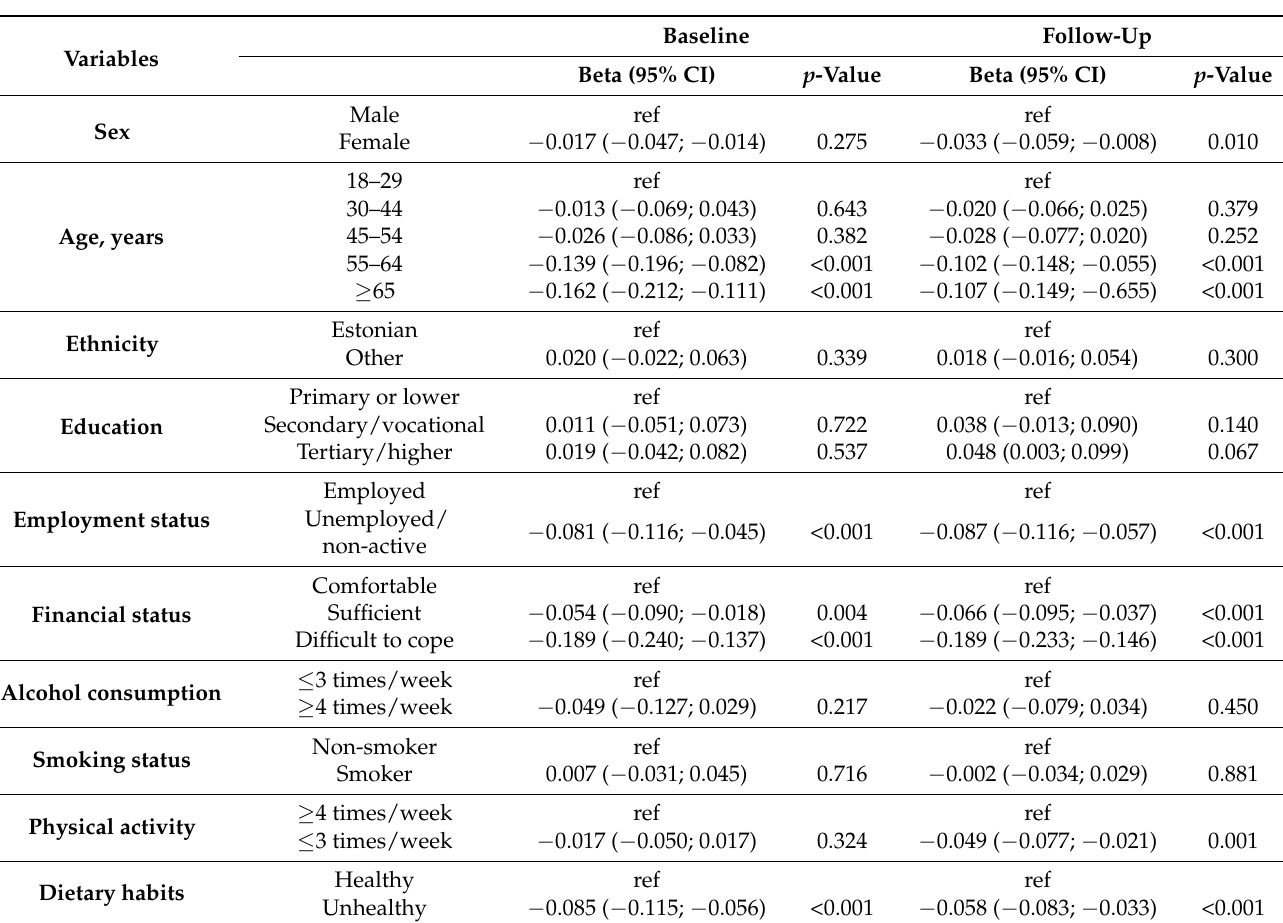
Figure 2. Proportion (%) with 95% confidence intervals of reported problems by EQ-5D domains at baseline and follow-up. Table 3. Relationship between EQ-5D-3L index score and demographic, socio-economic and health behaviour indicators at baseline and follow-up, Estonia